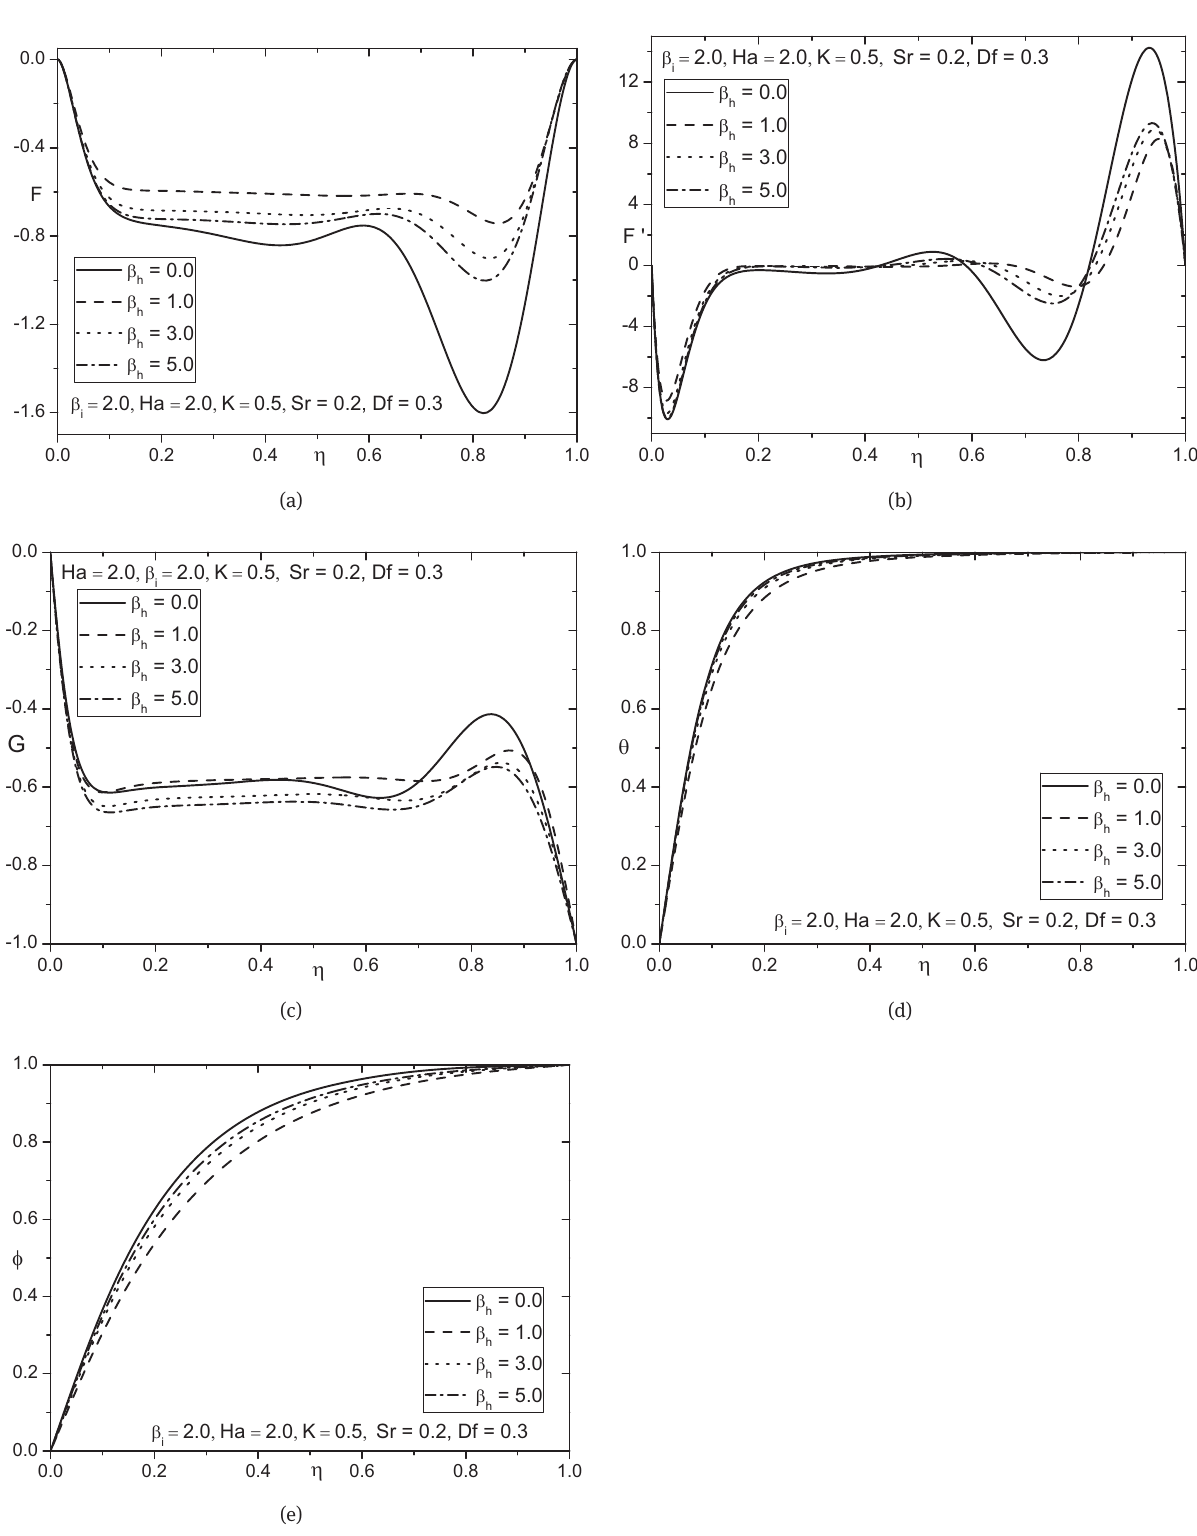
Fig. 4: Effect of Hall parameter on (a) axial velocity, (b) radial velocity, (c) tangential velocity, (d) temperature, and (e) concentration